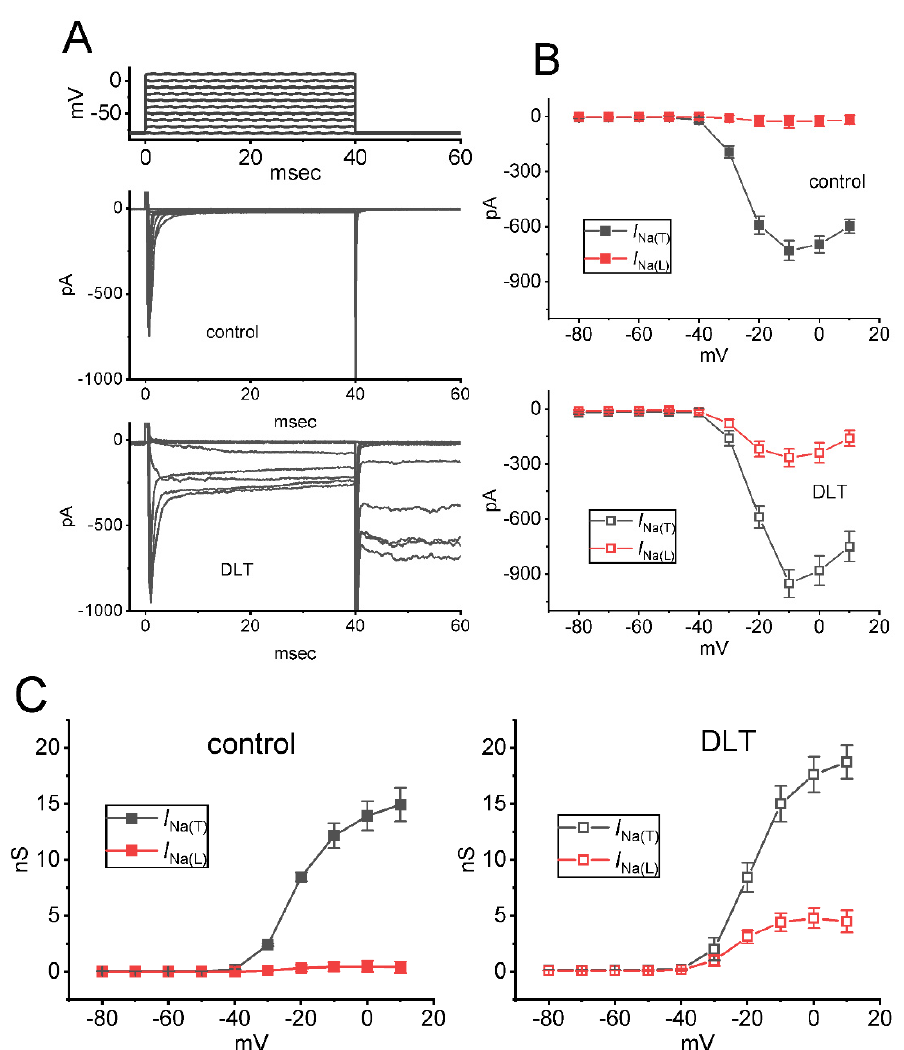
Figure 3. Effect of DLT on the steady-state current versus voltage (I-V) relationship of I Na(T) and I Na(L) identified from GH 3 cells. In this set of experiments, we held each cell at − 80 mV, and varying depolarizing command voltages from − 80 to +10 mV in 10-mV steps were delivered to evoke I Na(T) and I Na(L) . ( A ) Exemplar current traces obtained either in the control condition (upper) or with the presence of 10 μ M DLT (lower). The uppermost part is the voltage-clamp protocol given. ( B ) The mean I-V relationship of I Na(T) (black symbols) or I Na(L) (red symbols) in control (upper, solid symbols) and during exposure to 10 μ M DLT (lower, open symbols) (mean ± SEM; n = 8 for each point). Either I Na(T) or I Na(L) was measured at the beginning or end of each depolarizing pulse. ( C ) Conductance versus voltage relationship of I Na(T) (black symbols) or I Na(L) (red symbols) in the control period (left side) and during cell exposure to 10 μ M DLT (right side) (mean ± SEM; n = 8 for each point).